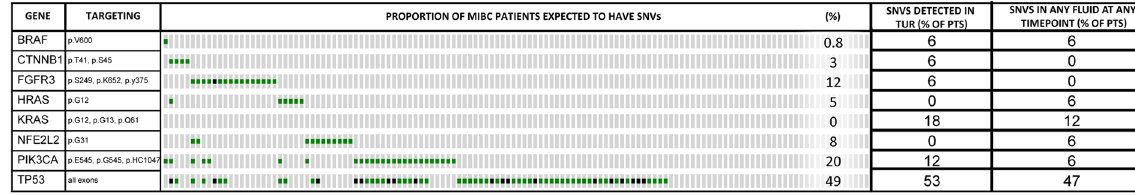
Figure 2. Genomic regions interrogated by TAm-Seq for SNV analysis. ^ Specificity of TERT assays was poor due to constraints of targeting short amplicons in the repetitive TERT promoter region. Data resulting from these assays were therefore excluded from downstream analysis. Other than TERT, 90–100% of mutations reported in the above listed genes were covered by the panel. Alterations in these genes would capture 72% of alterations reported in MIBC patients. The prevalence of the mutations shown here are based upon data generated by the TCGA Research Network: http://cancergenome.nih.gov/. Green squares represent missense mutations and black squares represent truncating mutations 38, 39 . The number of patients (and percentage of patients) with SNVs detected in TUR and in any body fluid at any time-point are shown for each